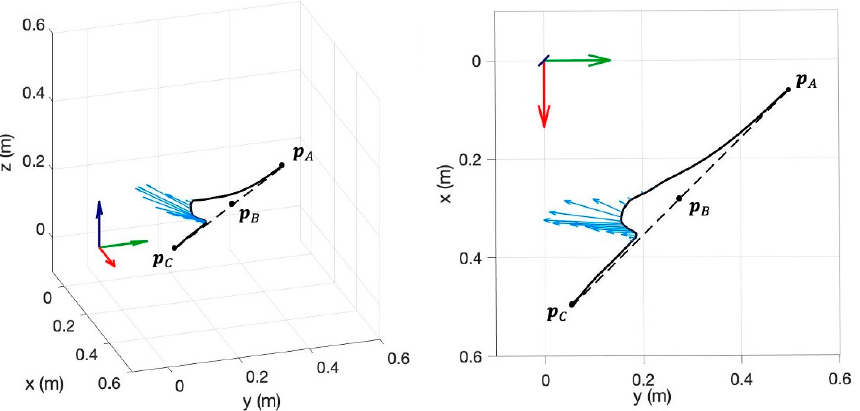
Figure 10. Collision avoidance trajectory during the “Place a ↦ A” stage.